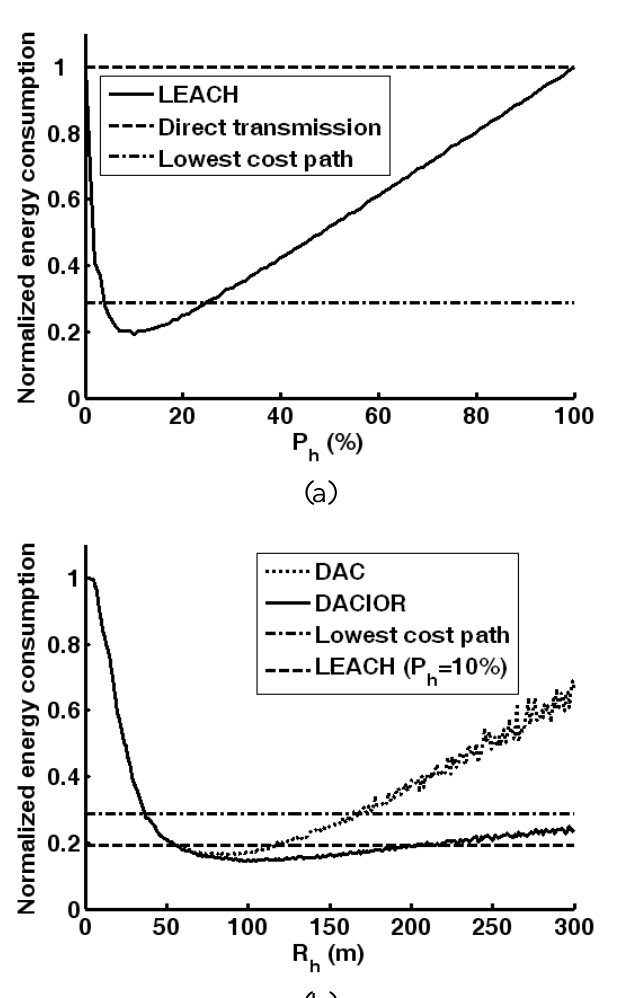
Figure 4. Energy efficiency comparison in global DAQ with different cluster head settings: (a) LEACH; (b) DAC and